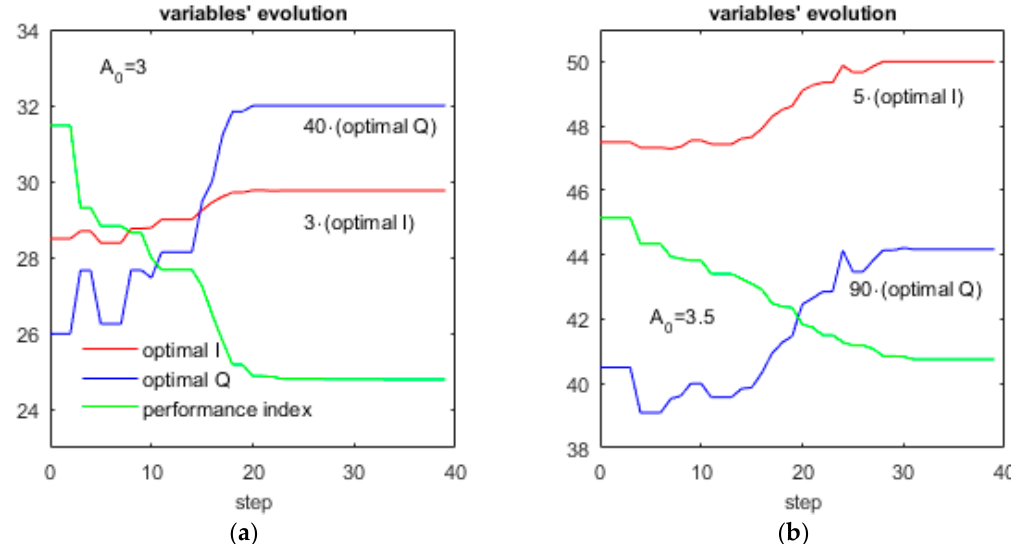
Figure 5. Typical evolution of variables during the execution of algorithm HTPSO_UV1 for the imposed values of two bacterial abatements: ( a ) A 0 = 3; ( b ) A 0 = 3.5.